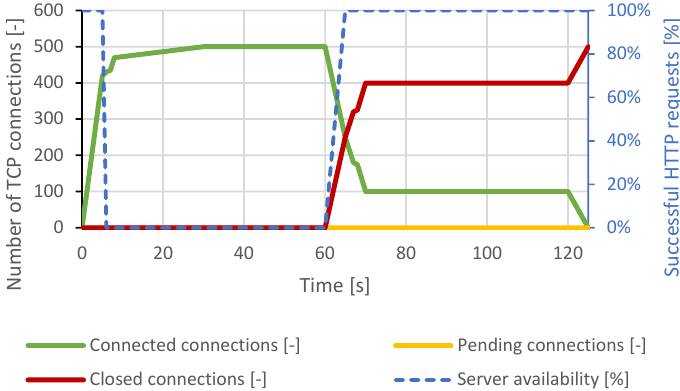
Figure 9. Slow Preface attack against Apache